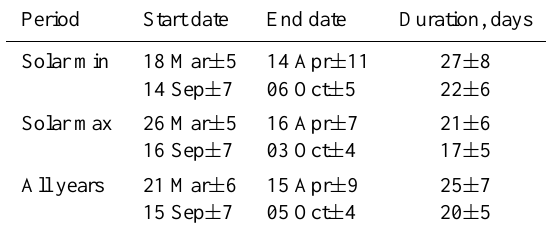
Table 4. Start and end dates and durations averaged over all stations of the equinoctial